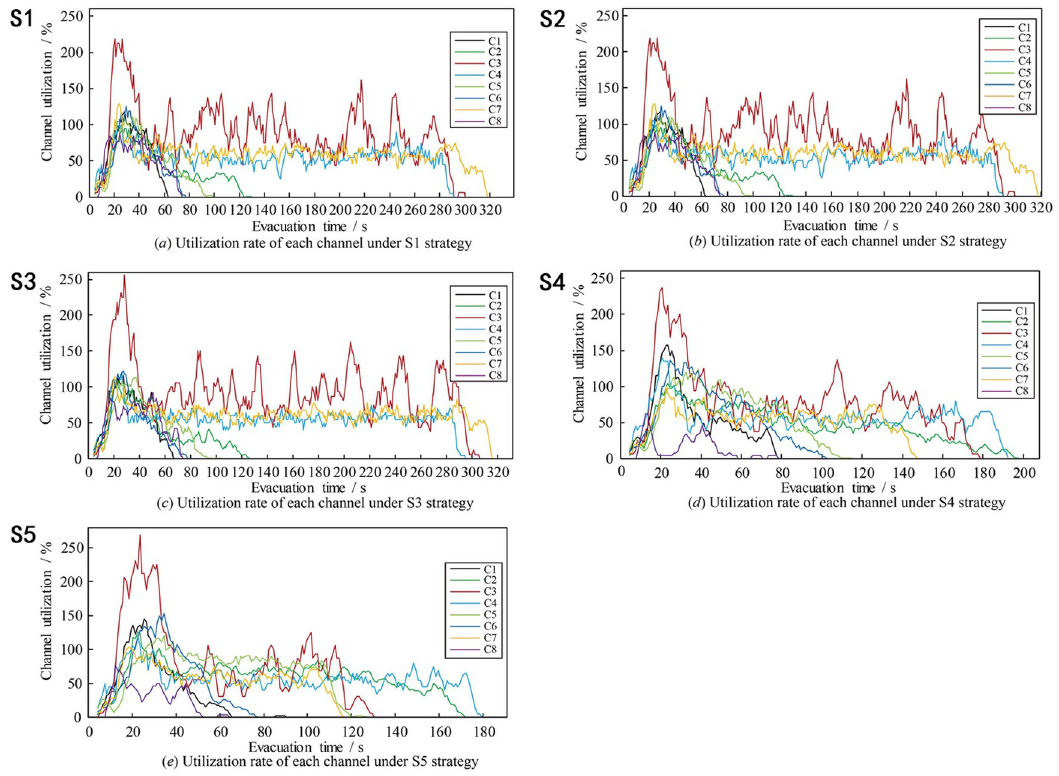
Fig 6. Results of channel utilization rate under five evacuation